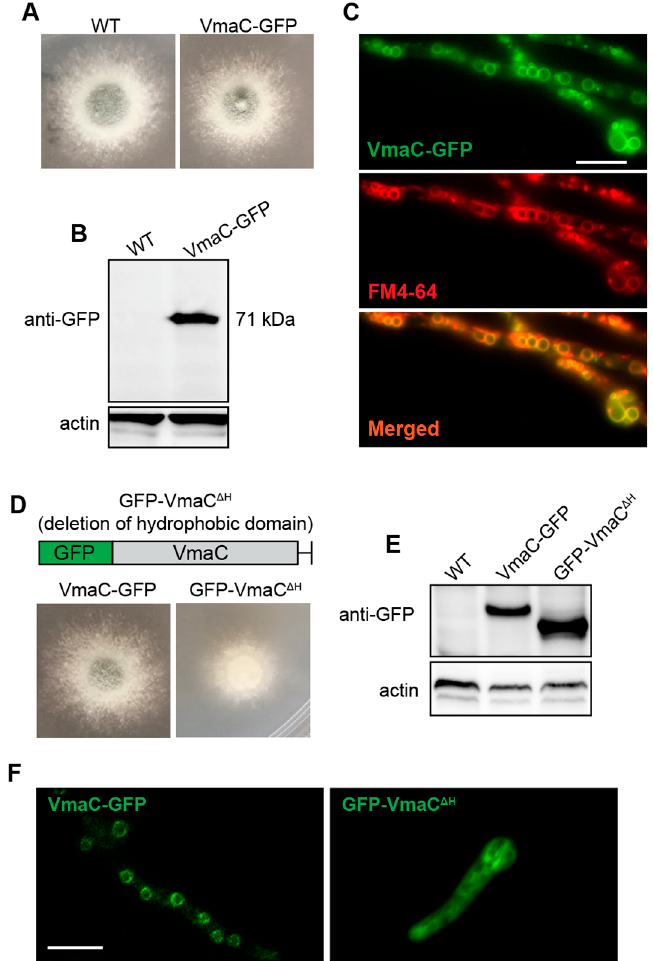
Figure 2. VmaC is localized in the vacuole. ( A , D ) Colony morphology of the VmaC-GFP strain and the VmaC C-terminal hydrophobic domain truncation mutant (VmaC ∆ H ) after culture at 37 ◦ C for 2 days. ( B , E ) Western blot analysis using an anti-GFP antibody indicated that the VmaC-GFP fusion protein was present and showed a predicted size of approximately 71 kDa. The VmaC C-terminal hydrophobic domain truncation mutant GFP-VmaC ∆ H showed the predicted truncated VmaC band. Actin was used as an internal loading control. ( C ) Colocalization of the C-terminal VmaC-GFP truncation strain with FM4-64 staining. The yellow color in the merged image indicates colocalization. ( F ) Localization in the VmaC ‐ GFP and GFP ‐ VmaC Δ H strains. Bar, 5 μ m.